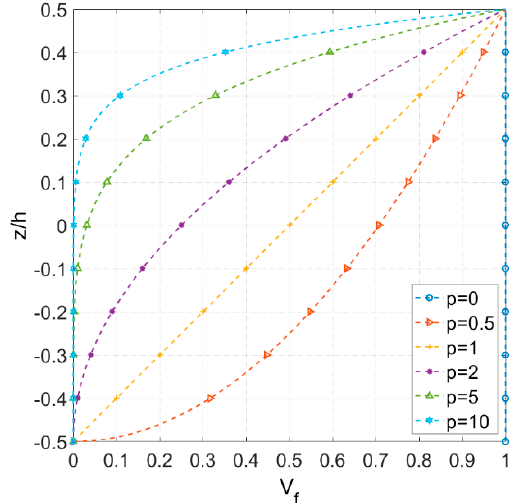
Figure 2. Evolution of the volume fraction through the thickness direction.